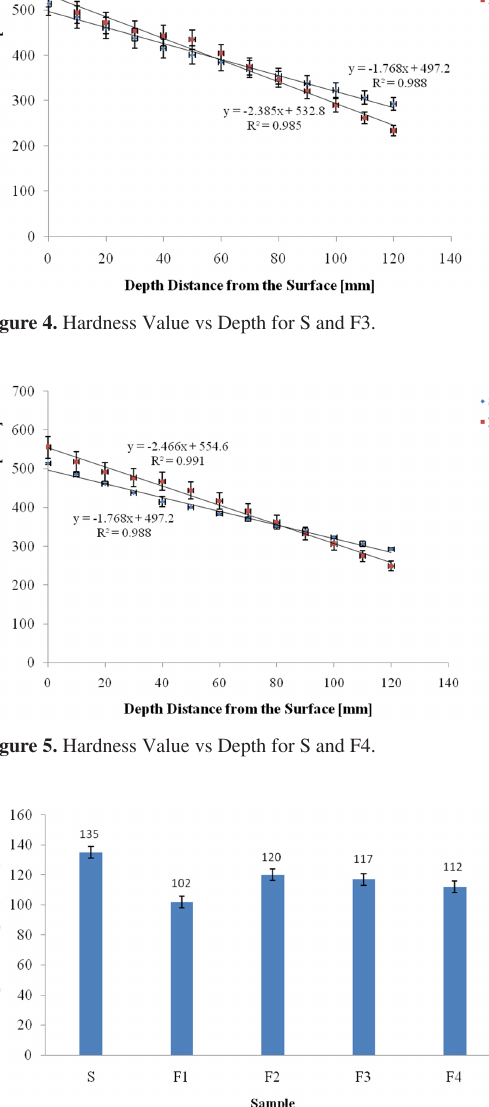
Figure 10. Optical micrograph of sample of failed crusher jaw